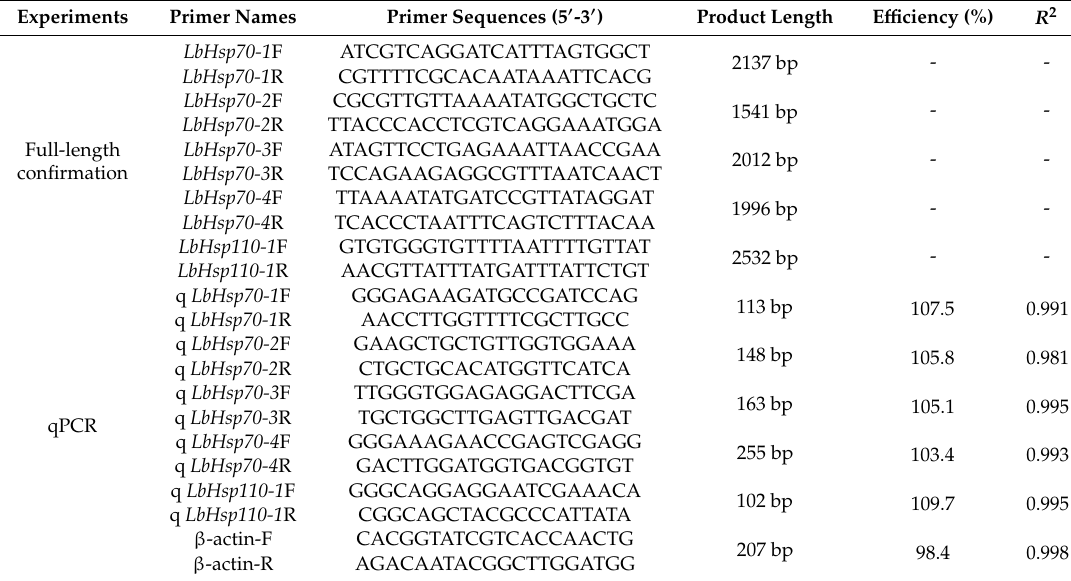
Table 1. Primers used for cloning and real-time quantitative PCR (qPCR) in this study.